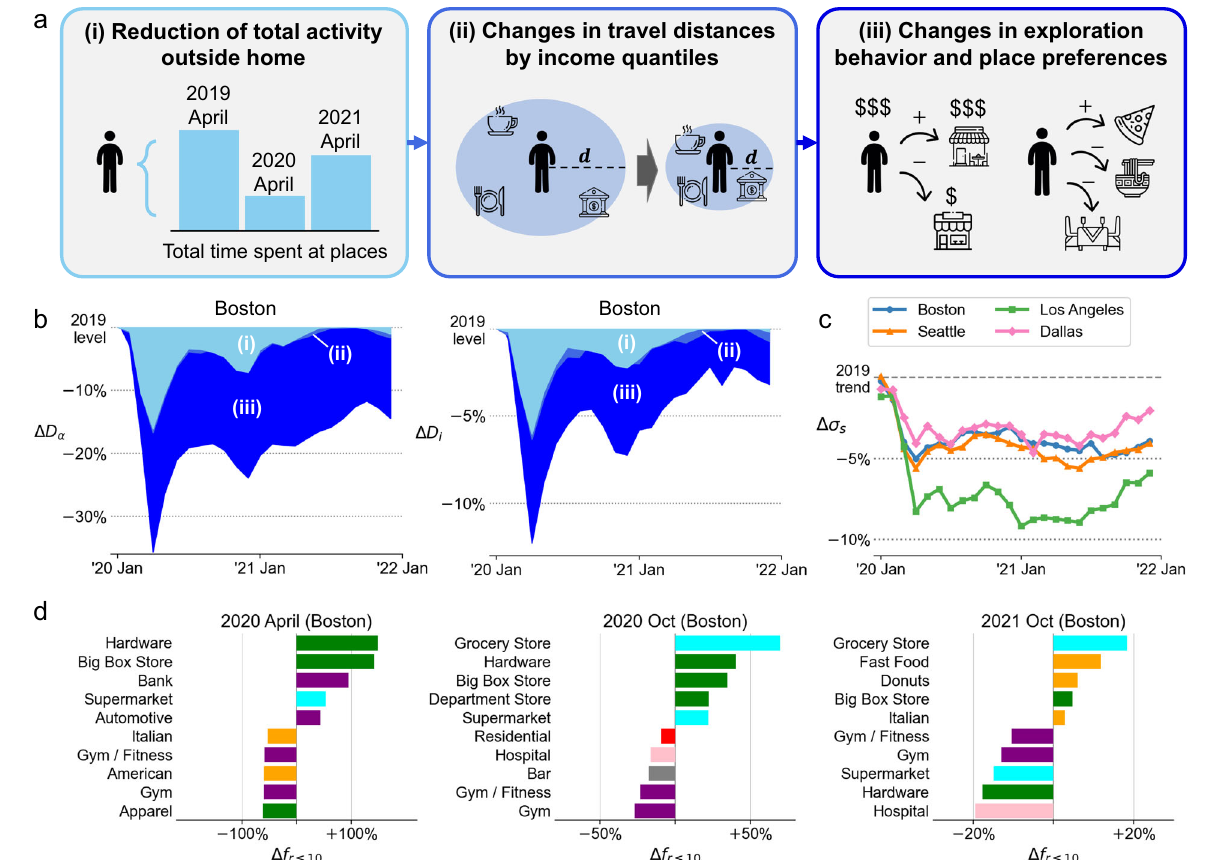
Fig. 2 | Behavioral changes decreased experienced income diversity in cities. a Threehierarchicallevelsofbehavioralchangesweresimulatedtounderstandwhy experienced income diversity decreased: (i) reduction in total outside activity by income groups, (ii) changes in traveled distances by income groups, and (iii) microscopic changes in mobility behavior, including exploration behavior and placesub-categorypreferences. b Decreaseinthediversityofencountersforplaces and individuals decomposed into the three behavioral factors for Boston. Coun- terfactual simulations show that reduction in total activities (i) in the short-term, and changes in exploration and place preferences (iii) in the long-term, were the major factors that decreased diversity. c Social exploration, which quanti fi es the